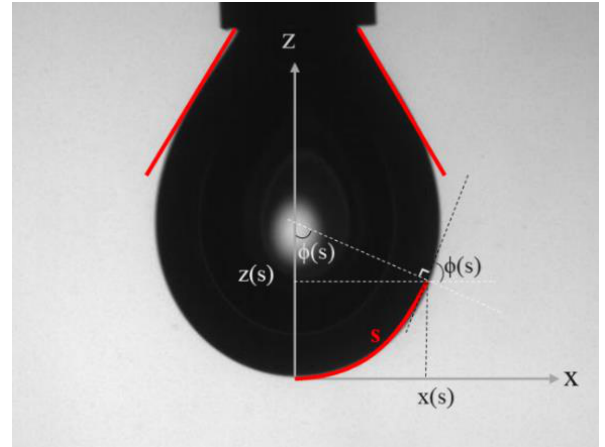
Figure 20. A pendant drop image indicating the coordinate system used for determining the surface tension. The drop shape is fit to a solution of the Young–Laplace equation.